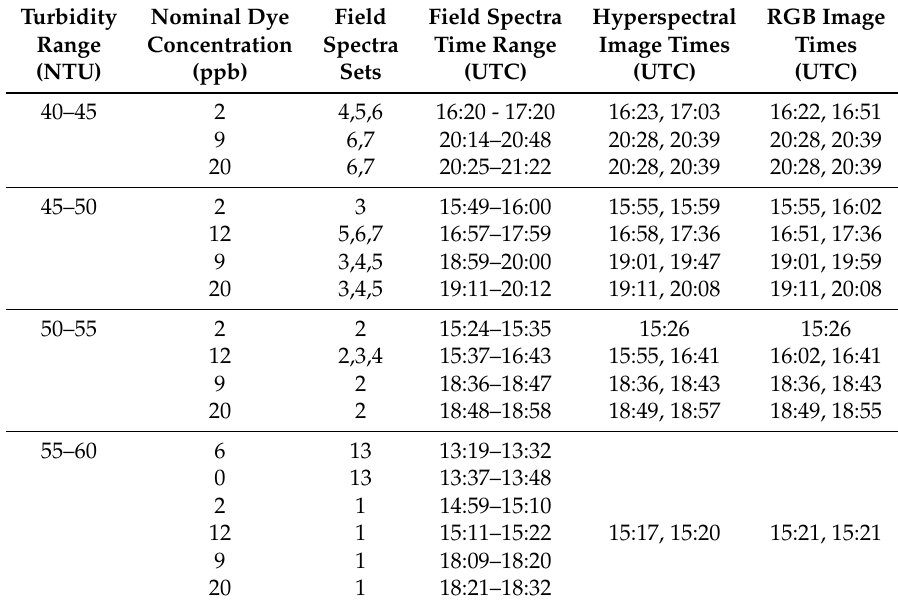
Table 1. Summary of data sets acquired during the experiment, organized into four distinct turbidity ranges. Hyperspectral images were selected to coincide as closely as possible with the timing of the field spectra and RGB images were selected to match the timing of the hyperspectral images.